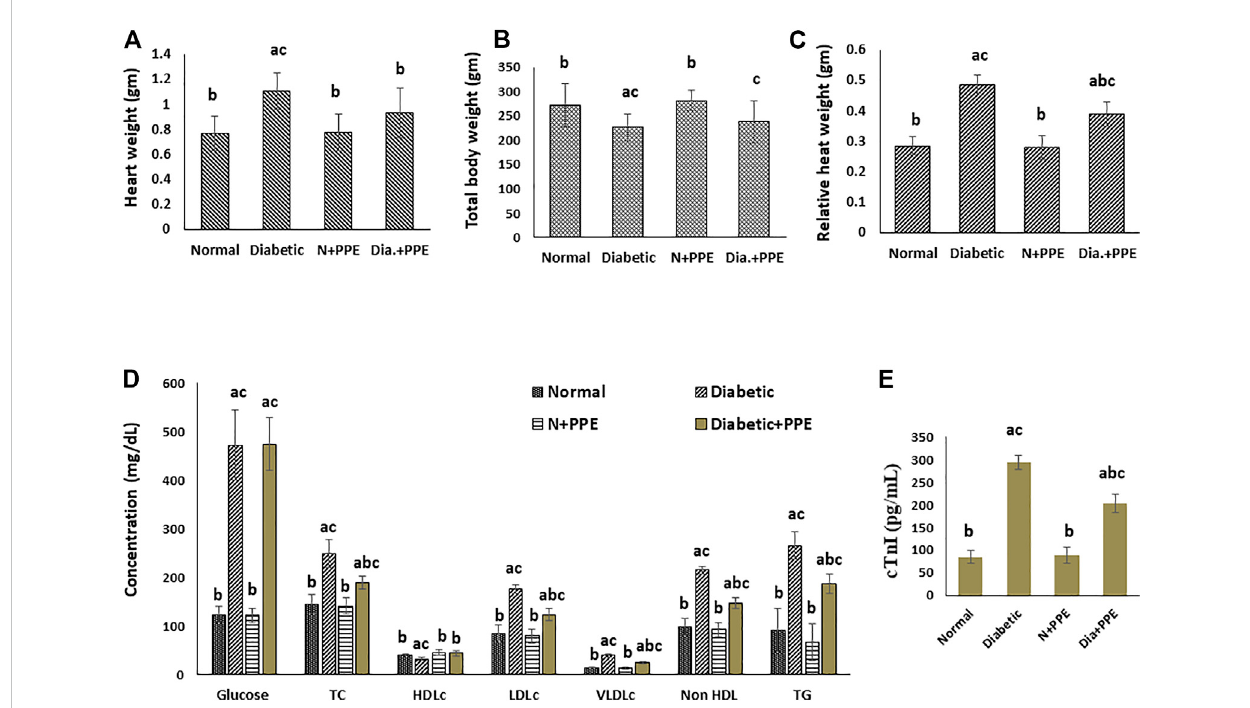
FIGURE 3 Effectofthepomegranatepeelextracttreatmentonthestudiedratgroups (A) heartweight, (B) totalbodyweight, (C) relativeheartweight, (D) randomblood glucoseandfastingserumlipids,and (E) serumcardiactroponin-Iconcentration.Dataarepresentedasmean±SD;n=7.cTn1:cardiactroponinI,Normal:normal rats(negativecontrolgroup),Diabetic:non-treateddiabeticrats(positivecontrolgroup),N+PPE:normalratstreatedwiththepomegranatepeelextract,Dia+PPE: diabeticratstreatedwiththepomegranatepeelextract.HDLc:highdensitylipoproteincholesterol,LDLc:lowdensitylipoproteincholesterol,NonHDL:non high density lipoprotein, TC: total cholesterol, TG: triglyceride, VLDLc: very low density lipoprotein